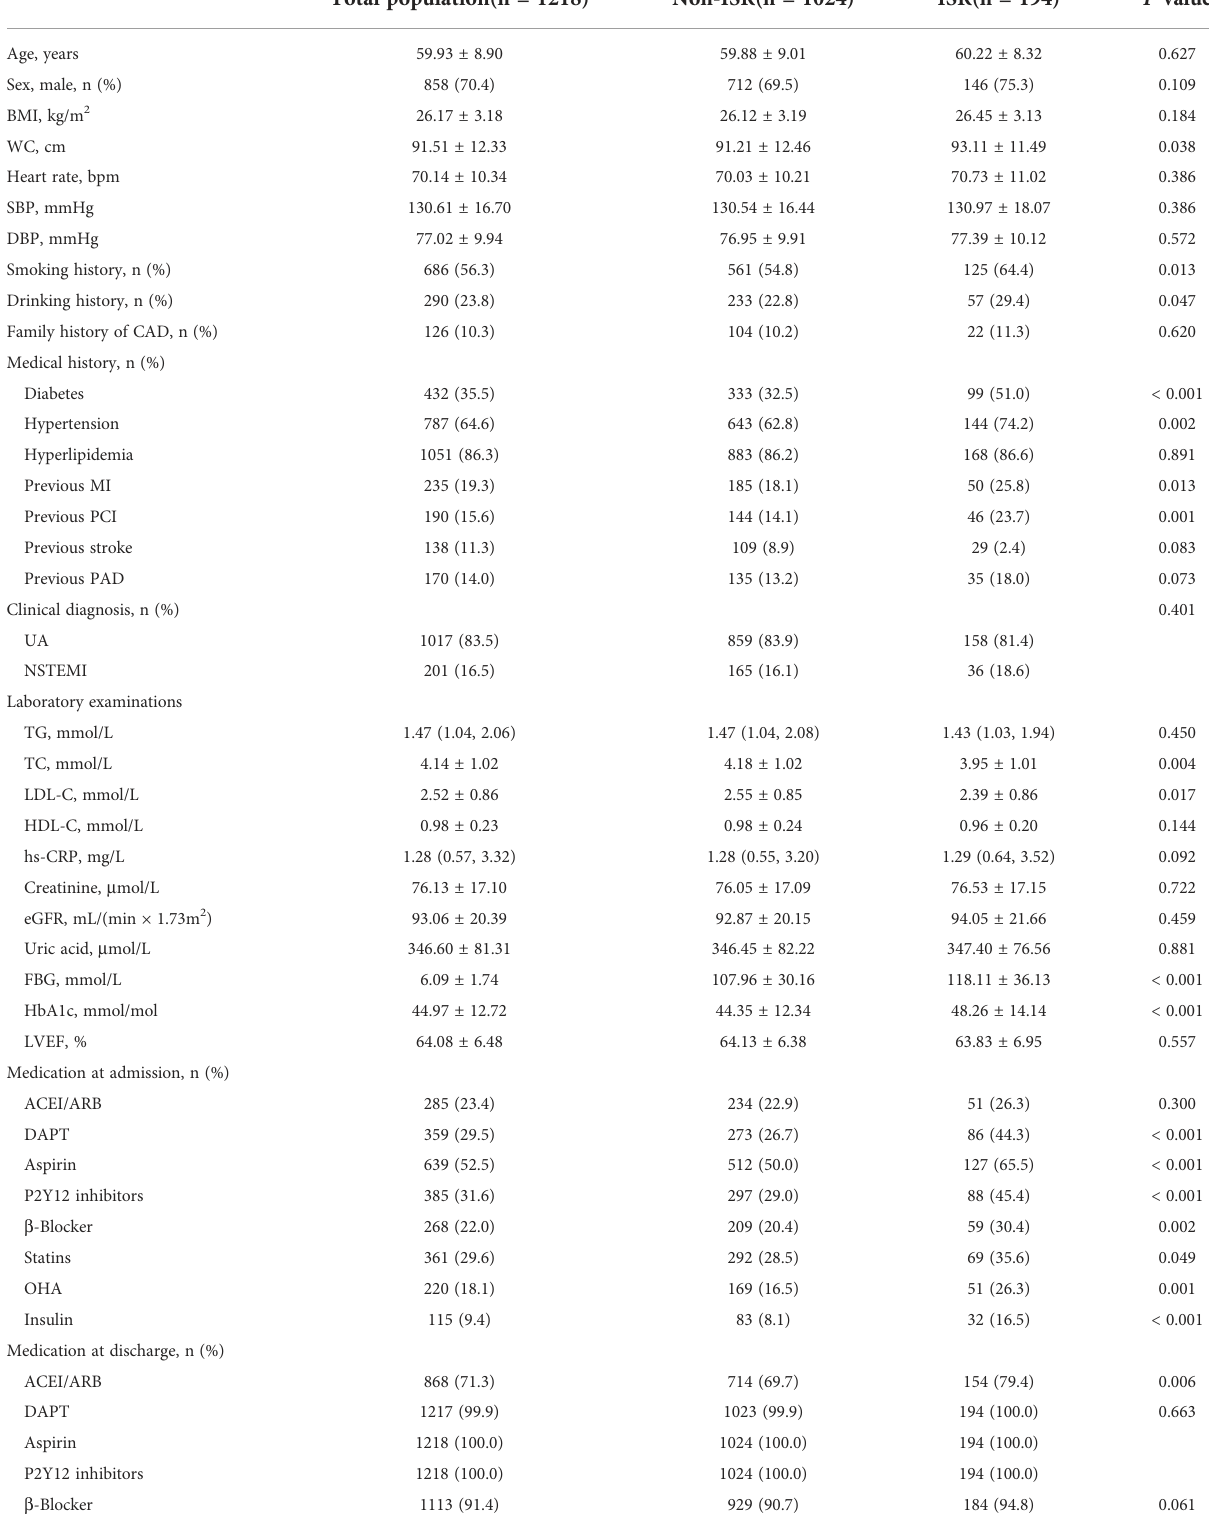
TABLE 1 Baseline characteristics of the study population based on